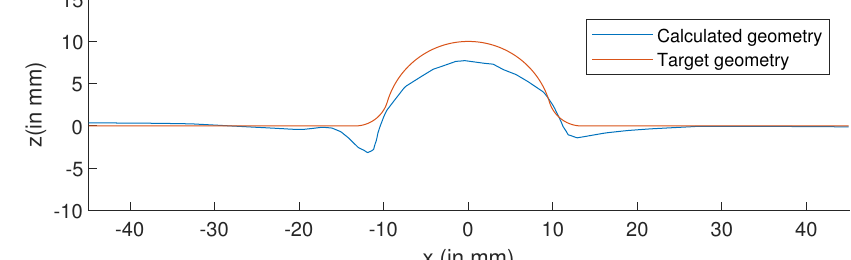
Figure 17. 2D Comparison between target and simulated geometry of inner part.